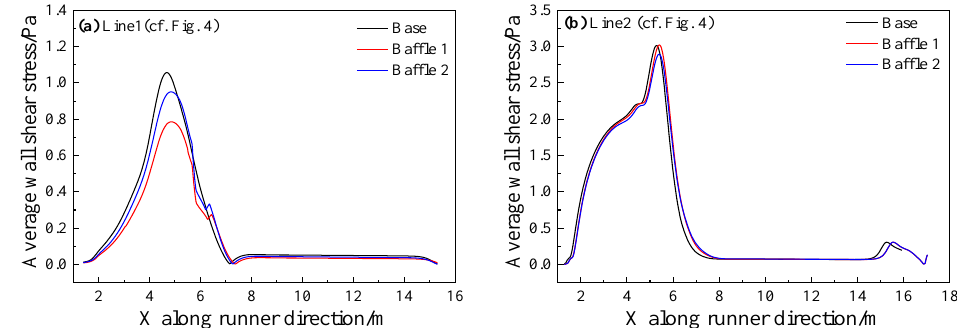
Figure 18. Time-averaged wall shear stress of the different main troughs.